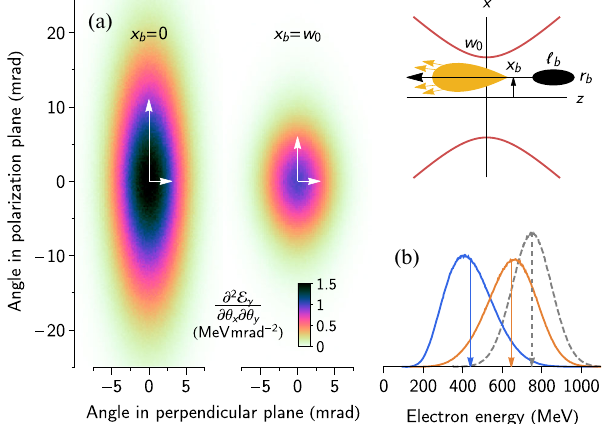
FIG. 4. (a) Energy radiated per unit solid angle (per electron) by an electron beam in a collision with a laser pulse that has peak a 0 ¼ 30 . White arrows indicate the standard deviations of the distributions. (b) Energy spectra of the electrons before the collision (gray, dashed curve) and after, when the beam offset ¼ 0 (blue curve) and x ¼ w from the laser axis is x 0 (orange b b curve). Arrows indicate the mean energy.